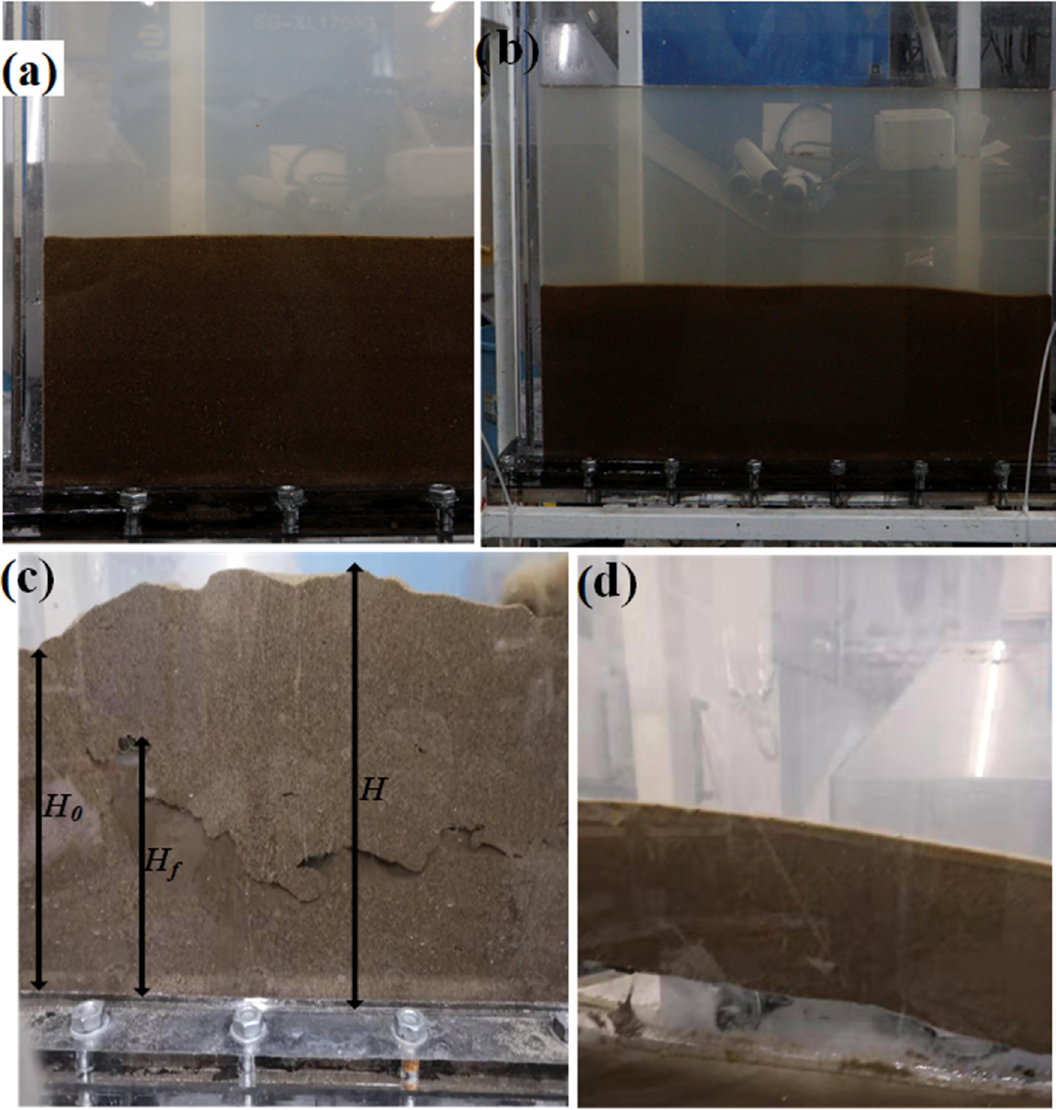
Figure 4. Transitional phases of destabilization: ( a ) starting sample of loose stack; ( b ) starting sample of dense stack; ( c ) turbulent and chaotic fluidization phase for the loose stack; ( d ) sand takeoff phase for the dense stack.